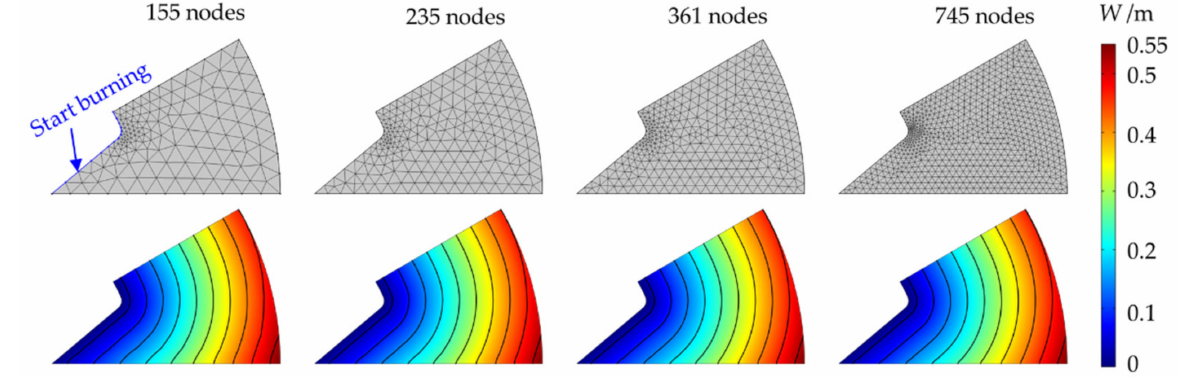
Figure 6. Results of burning surface regression for the typical star grain with different